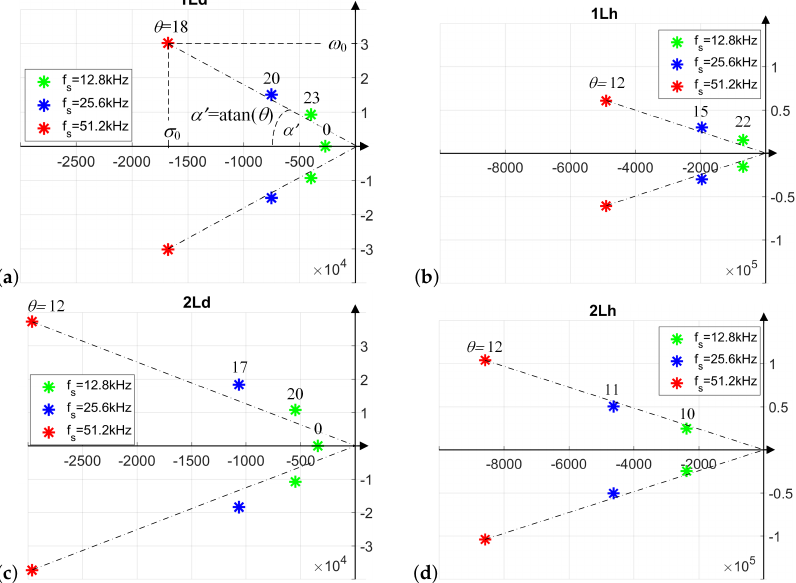
Figure 24. Dominant roots of the closed-loop systems. ( a , b ) single-loop systems, ( c ,( d ) double-loop systems. Axis scales other than in Figures 22 and 23 are used to show the details. Therefore, angle α = arctan θ differs from α (cid:48) . In particular, α = 86.8 ◦ , A i + 1 / A i = 0.70 for θ = 18, and α = 85.2 ◦ , A i + 1 / A i = 0.59 for θ = 12.